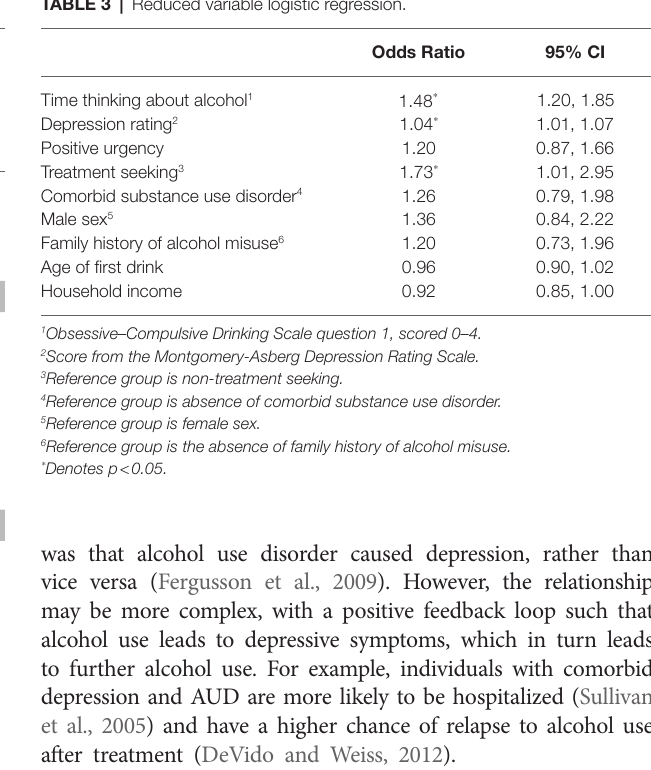
TABLE 2 | Group characteristics. TABLE 3 | Reduced variable logistic